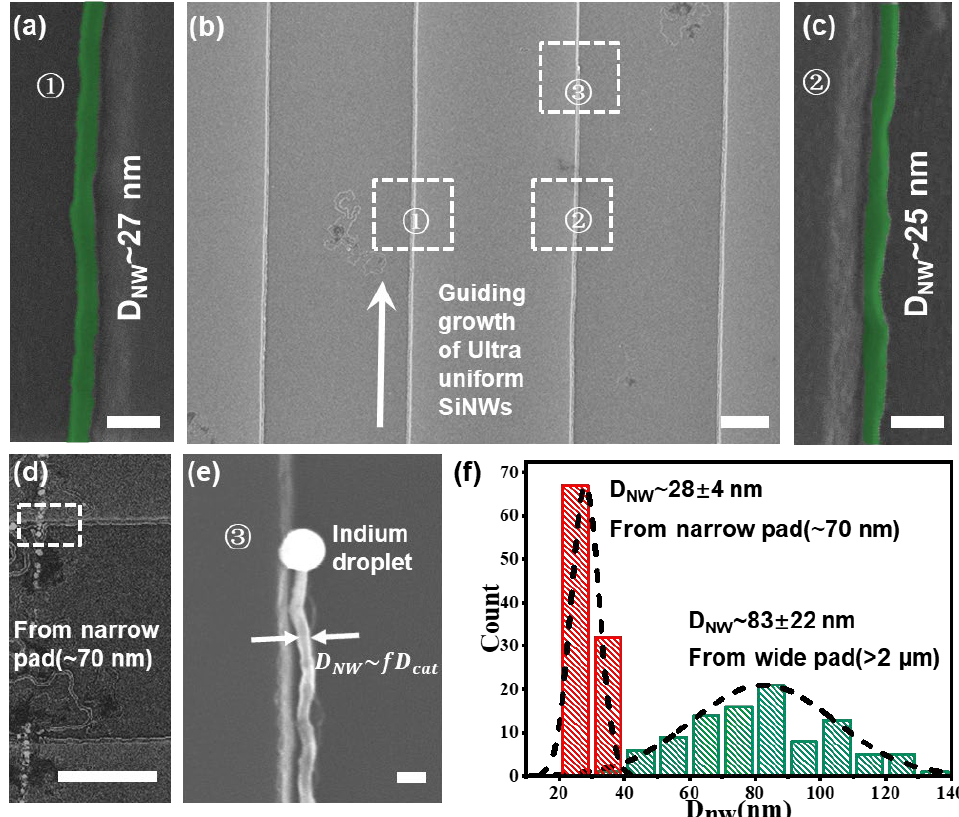
Figure 4. ( a – c ) SEM images of the IPSLS growth of uniform ultrathin SiNWs led by the uniform In droplets formed within nanostripes of W str ~ 70 nm, with diameters of 27 nm and 25 nm in ( a ) and ( c ), respectively. Close view of the ( d ) starting and ( e ) ending of a specific SiNW guided along the step edge. ( f ) The diameter statistics of the SiNWs grown from narrow In stripe (red) and wide stripe (green). Scale bars in ( a , c , e ) are for 100 nm, ( b , d ) stand for 1 μm.